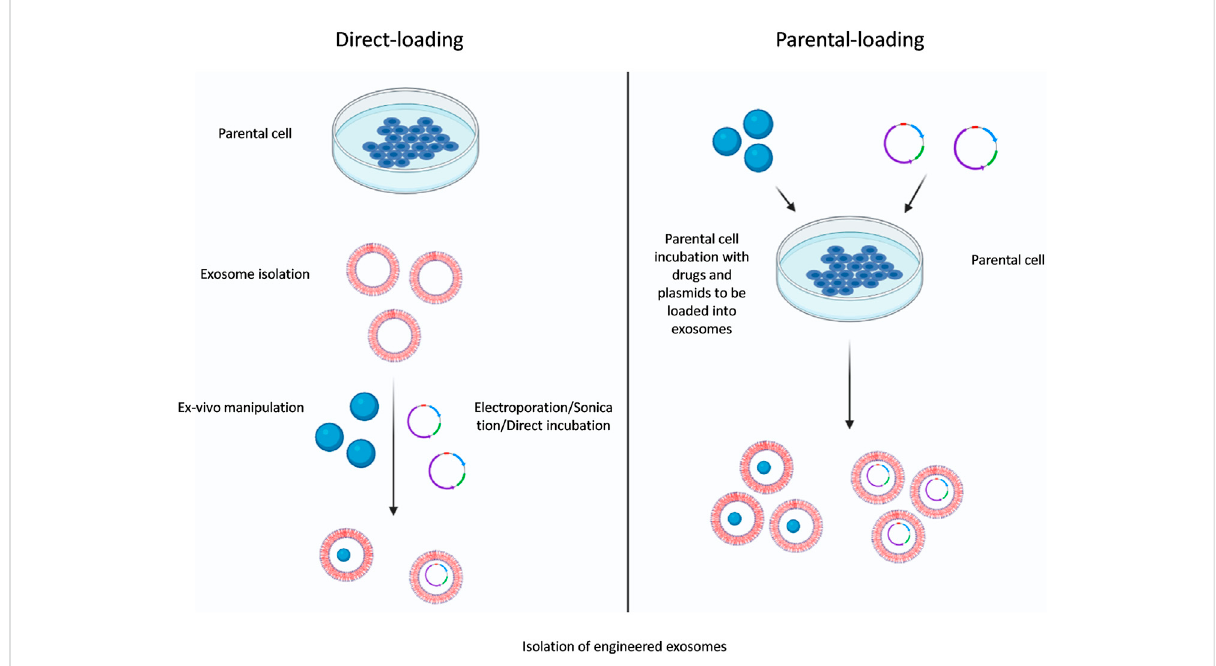
FIGURE 2 Exosomal-loading approaches. Two main approaches of exosome loading are parental cell-based and direct-loading engineering